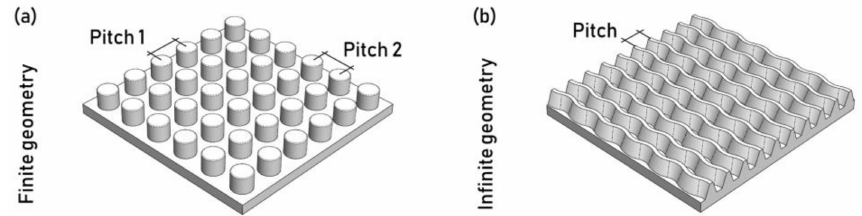
Figure 14. Schematic of ( a ) finite geometries pattern and ( b ) infinite geometries